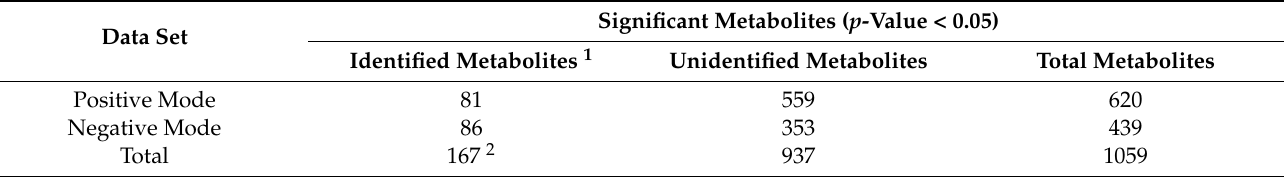
Table 1. Number of significant metabolites in X perforans with p -value < 0.05 analyzed by ANOVA in this study.